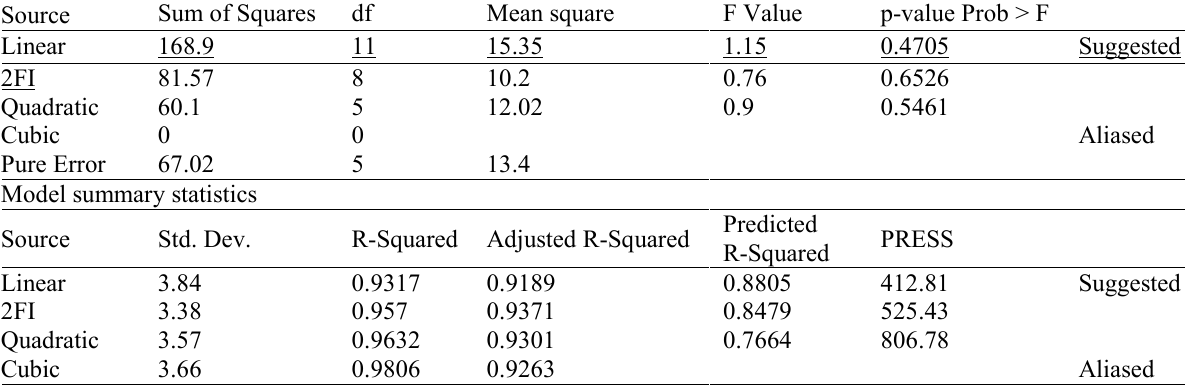
Table 5. Model sum of squares and the model summary statistics of TDS removal